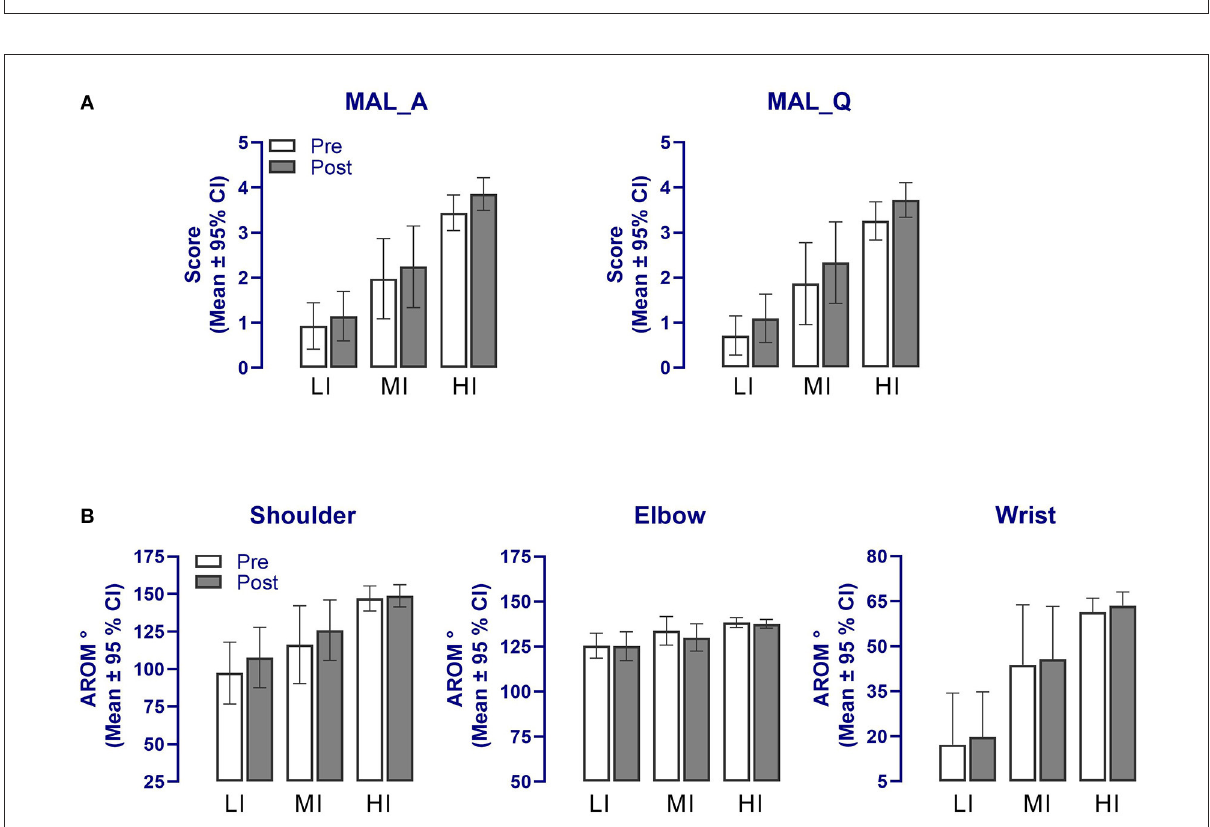
FIGURE4 Changes in the secondary outcome measures following the upper limb tailored strength training and anodal tDCS intervention in the three training groups for (A) the MAL and (B) affected upper limb AROM. A significant effect of “Time” was detected in all secondary outcomes ( p < 0.01) but no interaction with groups. Note that error bars for the wrist AROM are presented in one direction for clarity. MAL_A, Motor Activity Log amount of use; MAL_Q, Motor Activity Log quality of use; AROM, Active range of motion; LI, Low-intensity training group; MI, Moderate-intensity training group; HI, High-intensity training